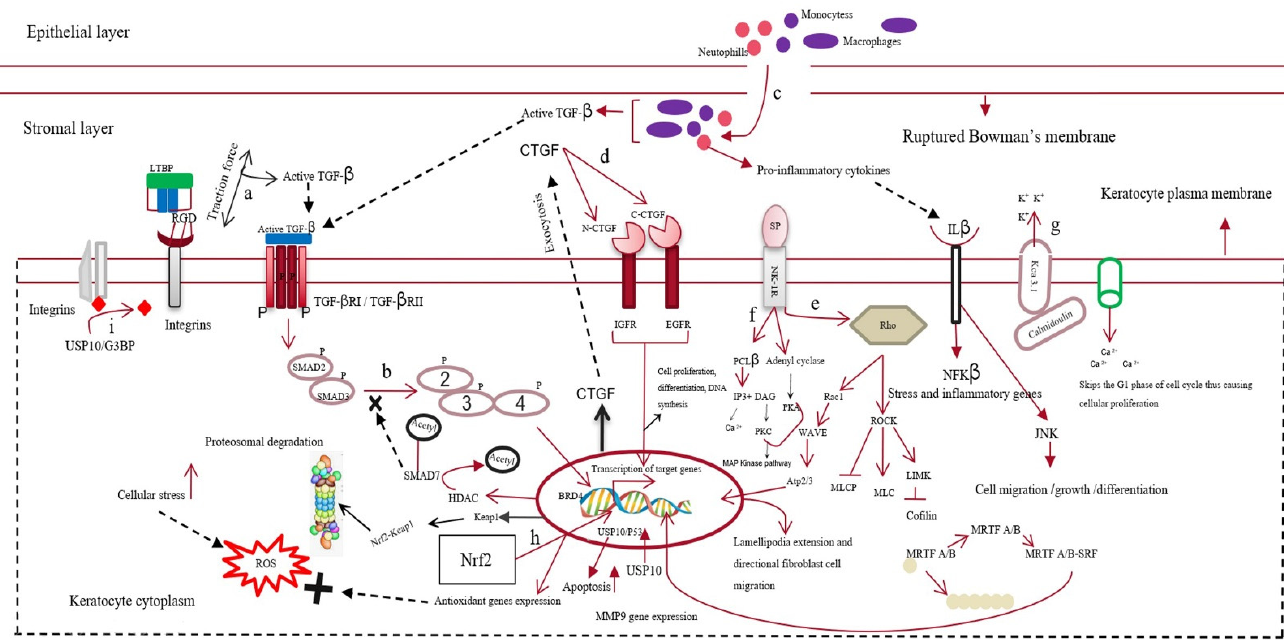
Figure 2. Mechanism of corneal scarring. This figure represents the keratocytes of the stromal layer, the epithelial layer, the disrupted Bowman’s membrane, and the stromal layer of the human cornea. The mechanism of corneal scarring is depicted in a single keratocyte cell for simplicity; ( a ) activation of transforming growth factor- β (TGF- β ) from its latent state; ( b ) SMAD-dependent TGF- β signaling pathway; ( c ) infiltration of neutrophils and macrophages into the stromal layer and their secretion of active TGF- β ; ( d ) CTGF (connective tissue growth factor) signaling pathway; ( e ) substance-P- mediated activation of the Rho/ROCK signaling cascade, leading to actin polymerization and MMP gene expression; ( f ) increase in intracellular Ca level by Substance-P-mediated PCL- β activation; ( g ) Kca3.1 ion-channel-mediated hyperpolarization of the keratocyte plasma membrane and subse- quent influx of Ca ions; ( h ) Nrf2 (nuclear factor erythroid 2–related factor 2)-mediated antioxidant gene production; however, BRD4 (bromodomain-containing protein 4) increases keap1 expression, leading to the formation of the kelch-like ECH-associated protein 1 (keap1)/Nrf2 complex and their subsequent degradation; ( i ) deubiquitylation of integrins by the USP10/G3BP complex.